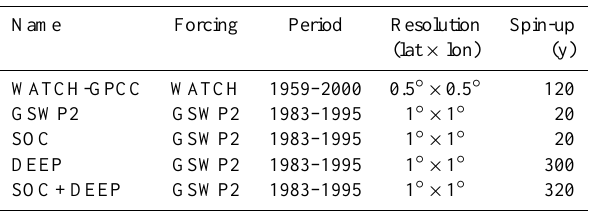
Table 3. JULES Northern Hemisphere grid experiments used in this